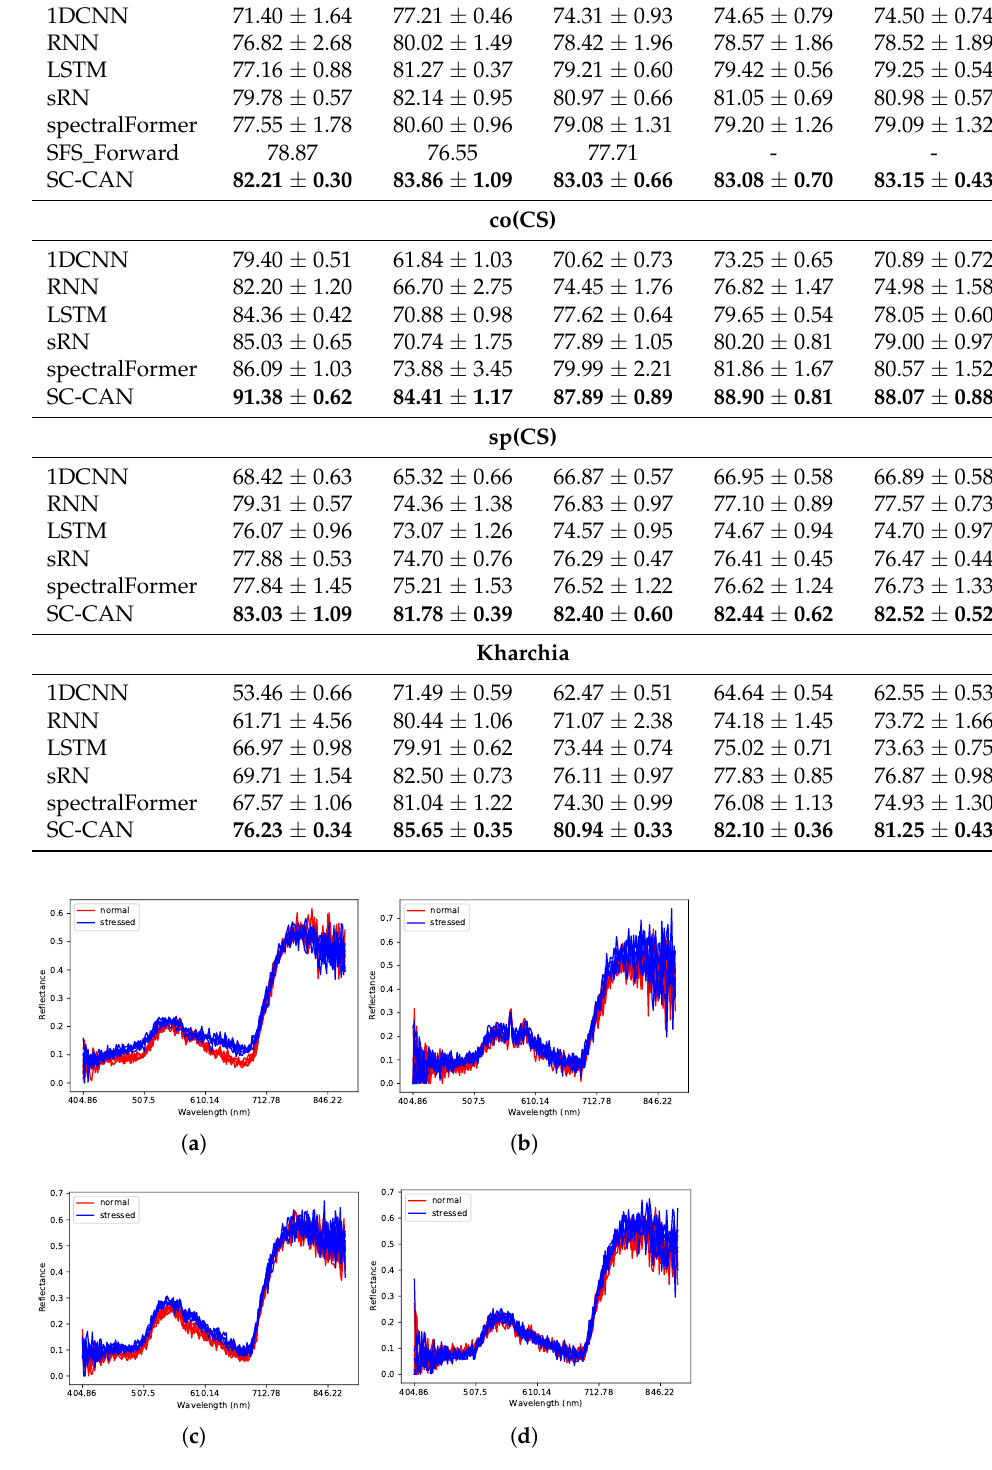
Figure 7. The spectral signal visualization from several samples ( a ) Example signal of healthy and salt stressed crops from co(CS) ( b ) CS, ( c ) sp(CS), and ( d ) Kharchia